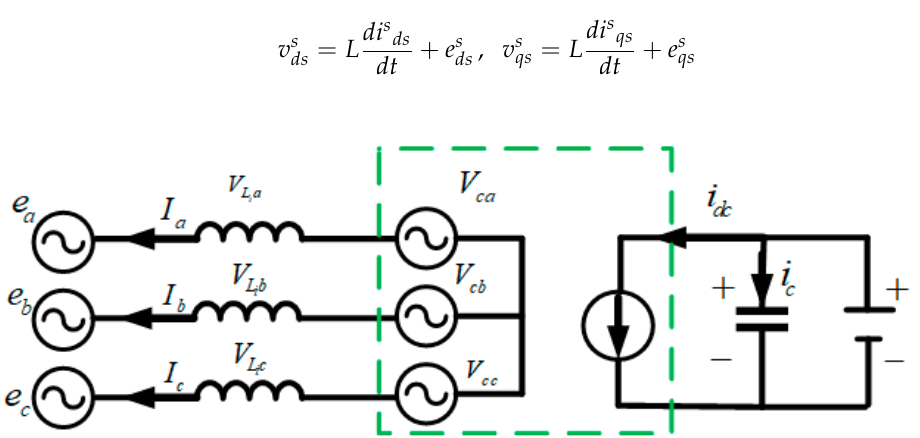
where e a , e b , e c : output voltages; i a , i b , i c : phase currents; and v a , v b , v c : control voltages. By converting the voltage equation of Equation (1) into a voltage equation of the two-phase stationary coordinate system, Equation (2) is obtained as follows: